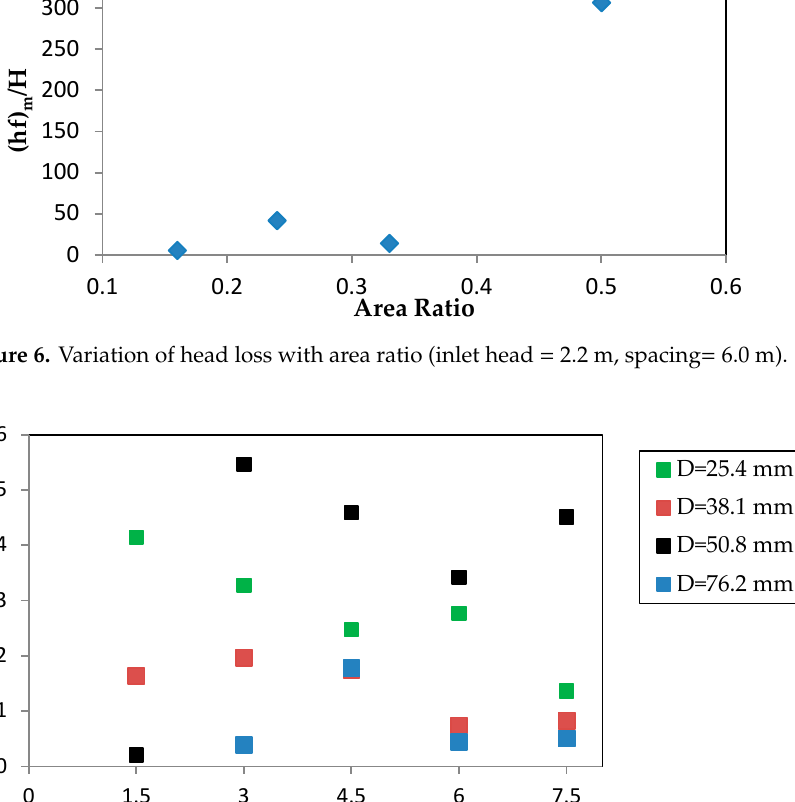
Figure 5. Variation of the pressure head for various area ratios (inlet head = 1.7 m, spacing = 6.0 m).